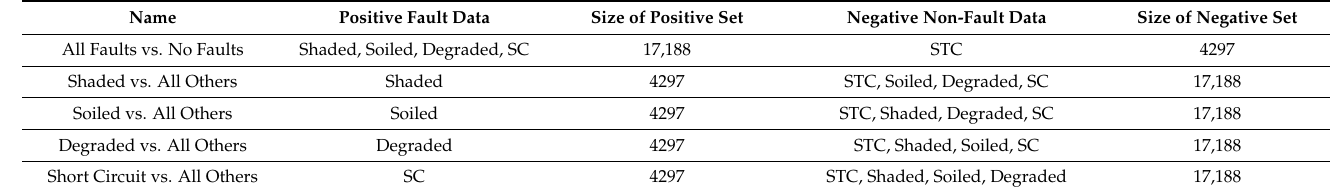
Table 1. The binary composition of the five compared fault